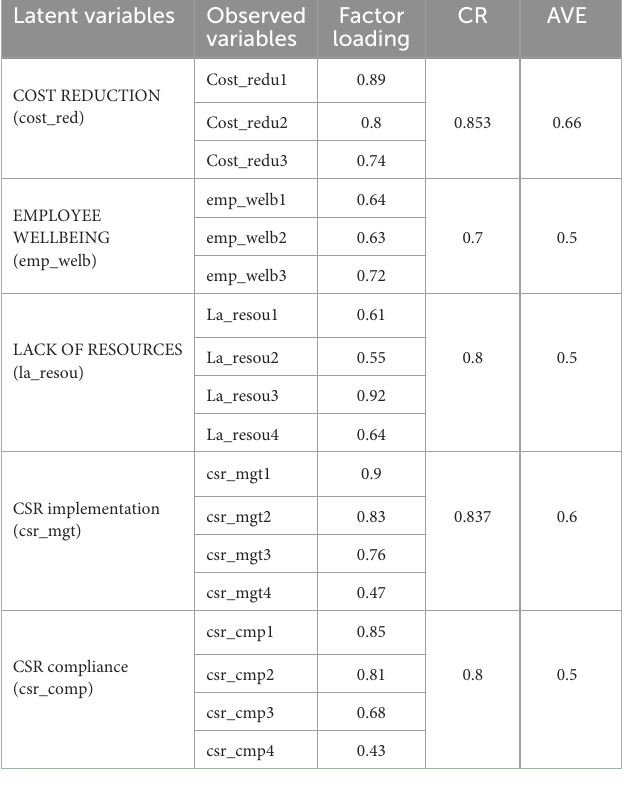
TABLE 2 Model fit.